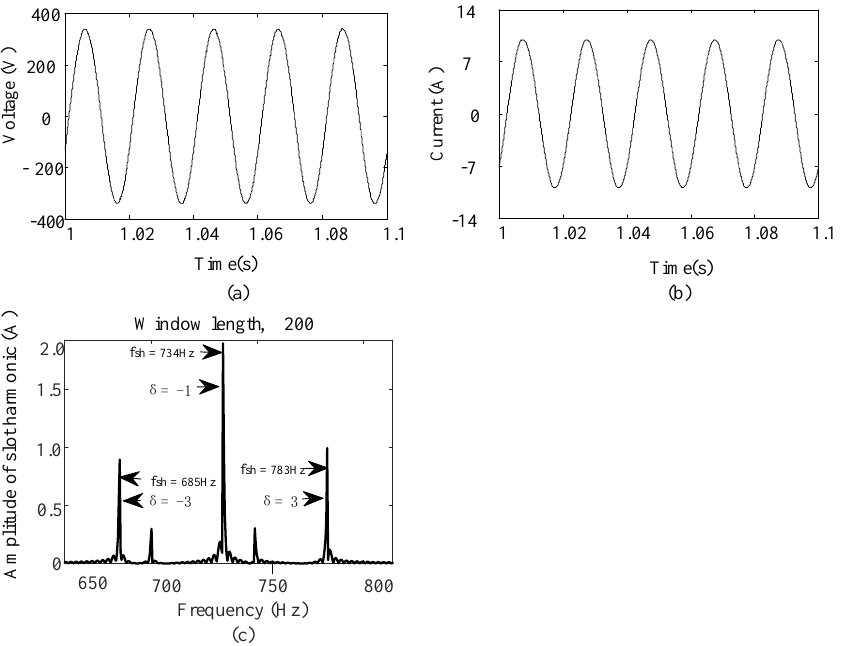
Figure 4. ( a ) Voltage waveform; ( b ) current waveform; ( c ) extracted slot harmonic frequency f sh = 734 Hz, speed n = 1466 r/min.